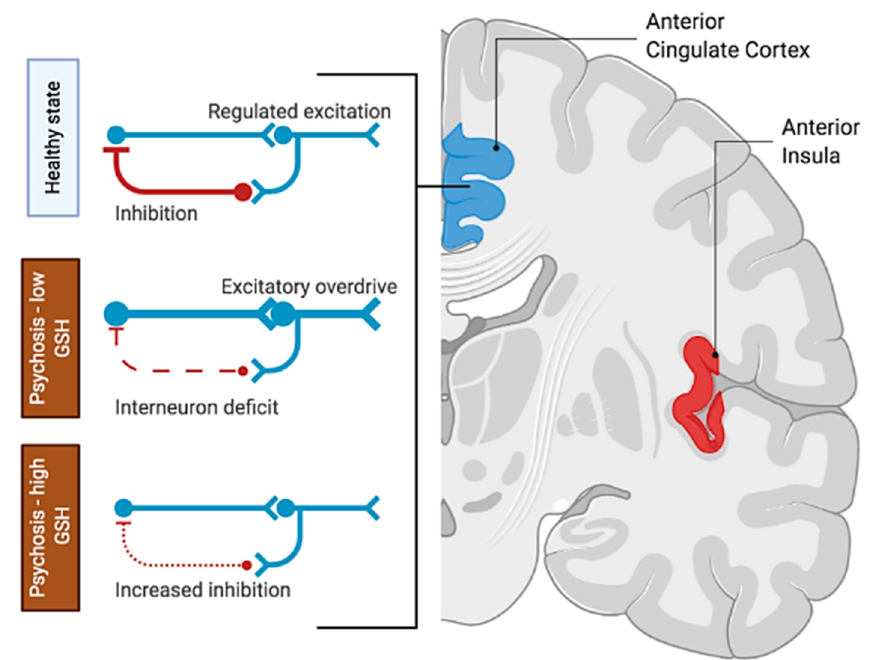
Figure 5. Summary of the counteracting effect of GSH on redox imbalance in the salience network. In a healthy state, the excitation–inhibition balance is achieved via the interplay of excitatory and feedback inhibitory neuronal populations. Glutamate-mediated dysconnectivity in psychosis (likely caused by GSH depletion in the developing brain) would manifest in terms of interneuron deficit, leading to excitatory overdrive (i.e., hyperglutamatergic state). The resulting excitatory overdrive can be reduced by increasing inhibition via a compensatory increase in the levels of GSH, at least in a subset of patients. This illustration was produced using biorender.com